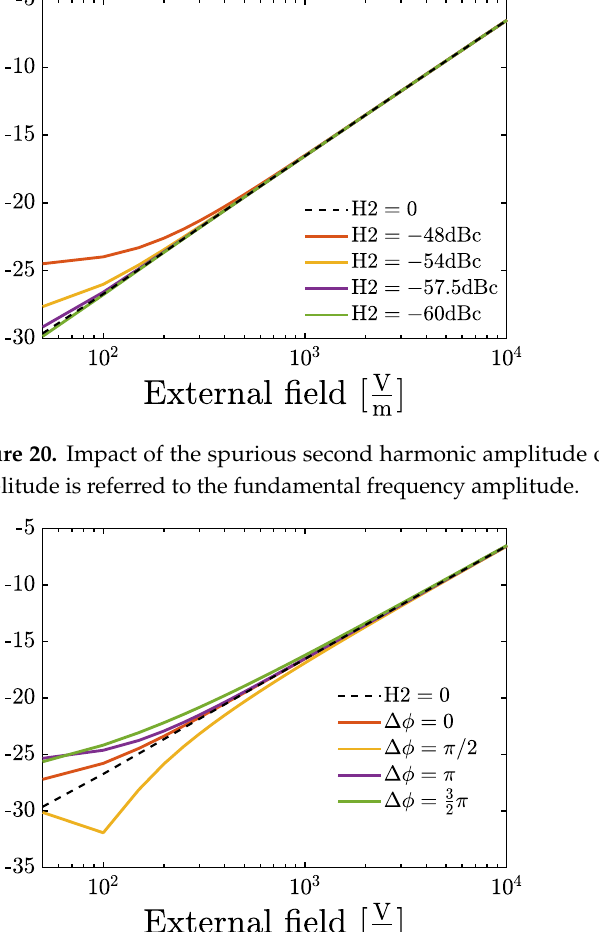
Figure 21. Impact of the phase difference between the spurious second harmonic and the fundamental frequency. The calculations were done for H2 = − 54